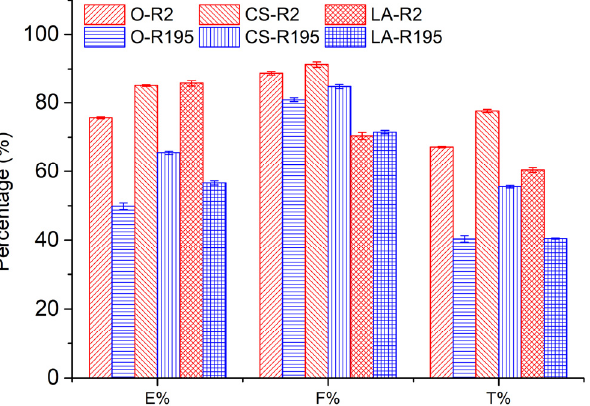
Figure 4. Dyeing performance of woven cotton fabric pre-mercerized by CS and LA using R2 and R195 dyes.